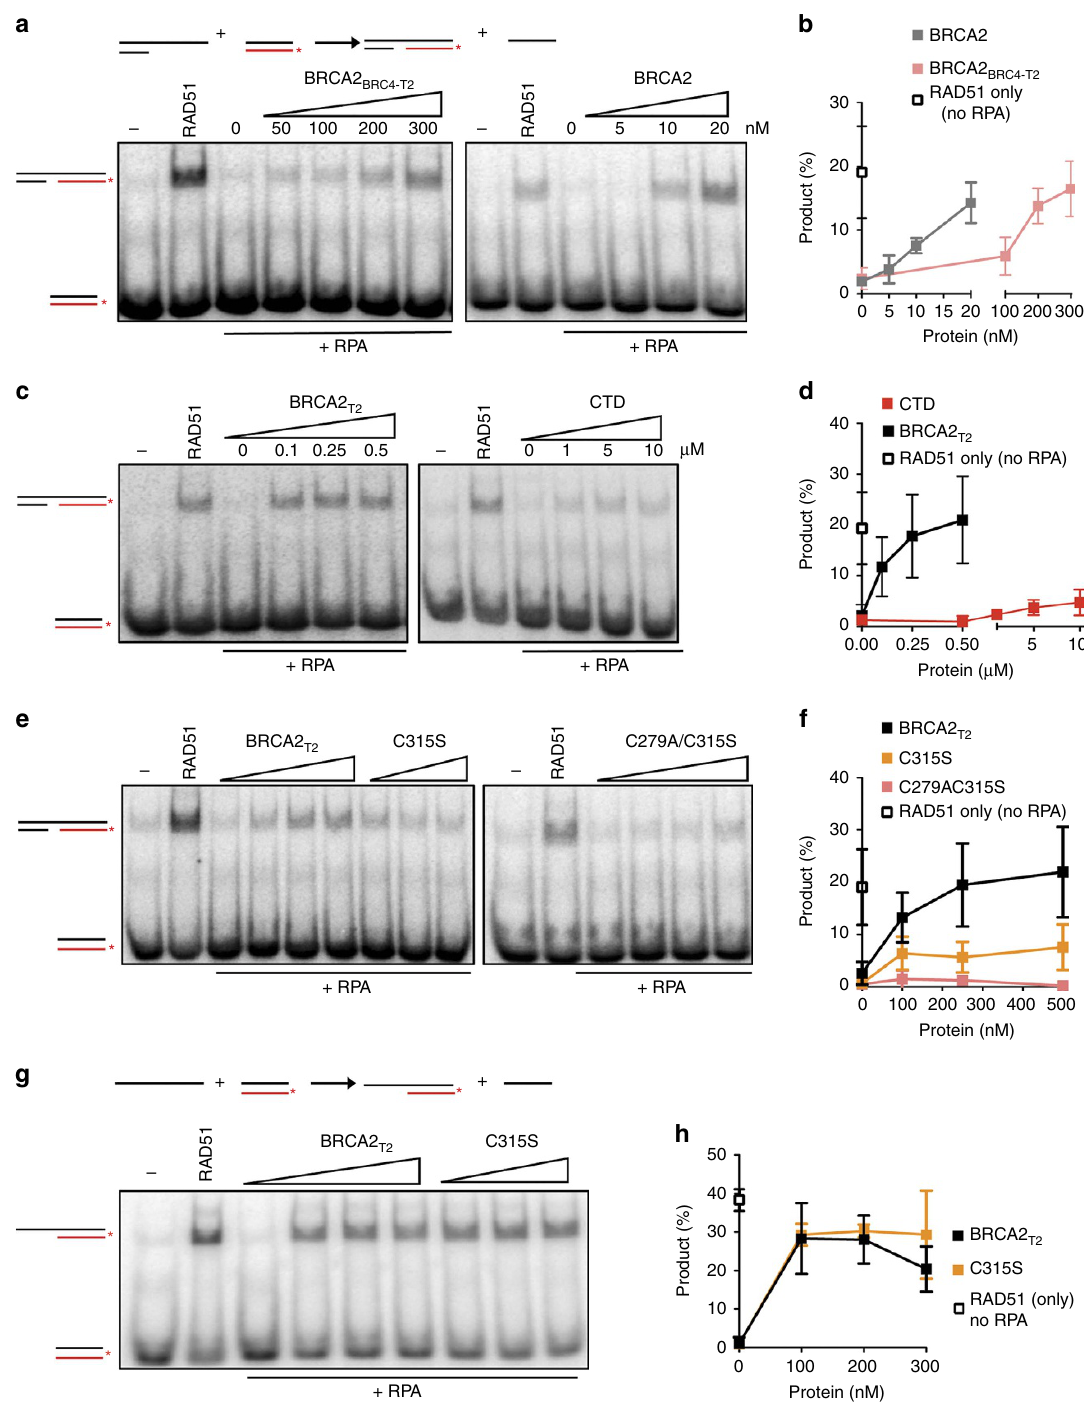
Figure 4 | BRCA2 T2-BRC4 and BRCA2 T2 stimulate RAD51-promoted DNA strand exchange. ( a ) DNA strand exchange reaction using a 3’ overhang ssDNA substrate (scheme on top) in the presence or absence of RPA, RAD51, and increasing concentrations of BRCA2 BRC4-T2 or BRCA2. ( b ) Quantification of ( a , c ), same reaction as in a with increasing concentrations of BRCA2 T2 or CTD. ( d ) Quantification of ( c , e ), same reaction as in a with increasing concentrations of BRCA2 T2 or BRCA2 T2 mutant in C315S, or C279A/C315S, as indicated. ( f ) Quantification of ( e , g ), same reaction as in a using a ssDNA substrate (scheme on top) with increasing concentrations of BRCA2 BRC4-T2 or BRCA2 T2 mutant C315S, as indicated. ( h ) Quantification of g . Error bars, s.d. ( n ¼